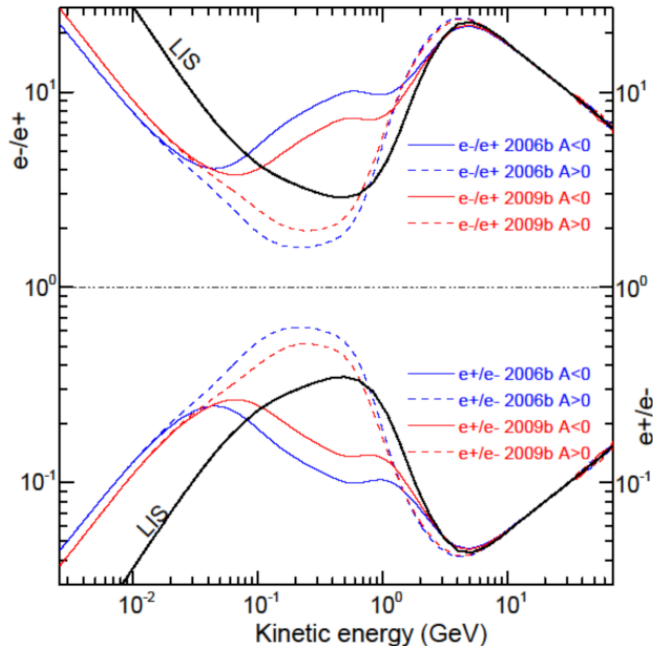
Figure 12. Same as Figure 11 (solid lines), but showing additionally ratios predicted for an A > 0 drift cycle, the present minimum epoch (dashed lines), assuming identical modulation conditions as in 2006b and 009b, respectively; following the colour coding as indicated in the legends.